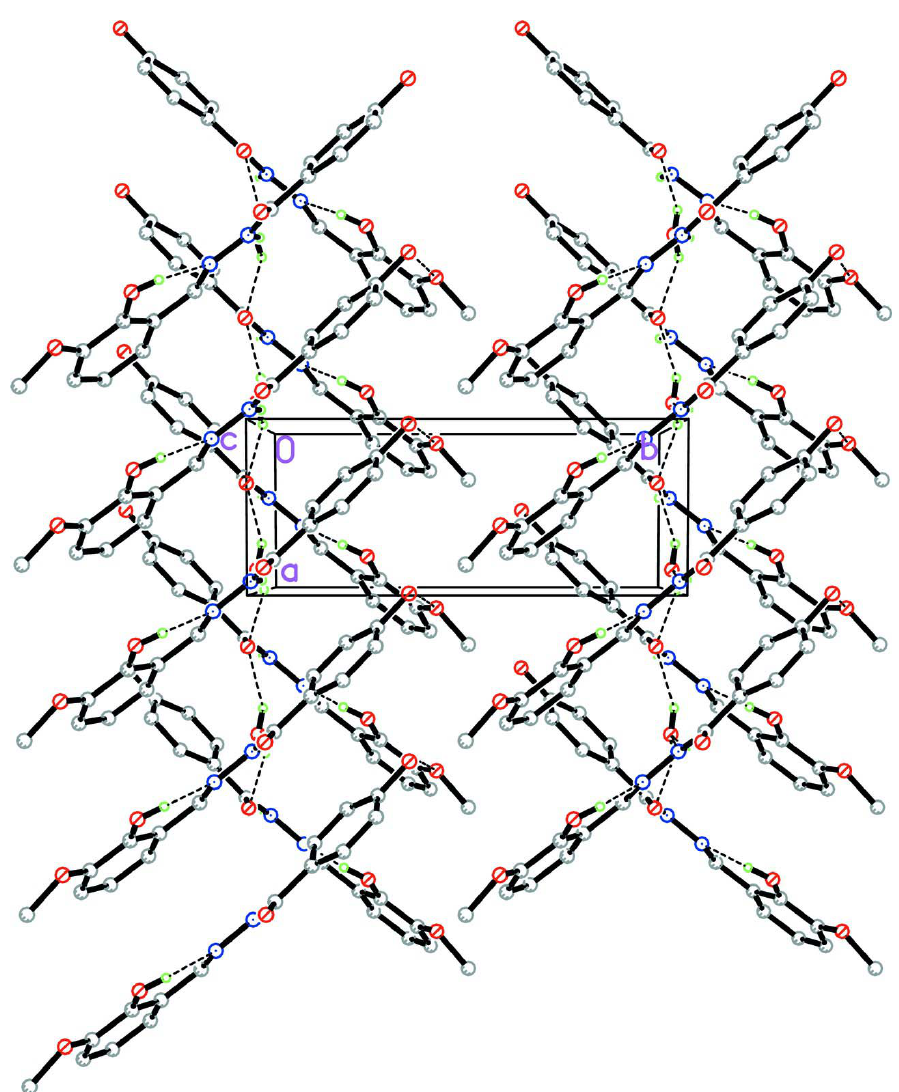
The crystal packing of the title compound, viewed along the c axis. H atoms not involved in hydrogen bonding (dashed lines) have been omitted for